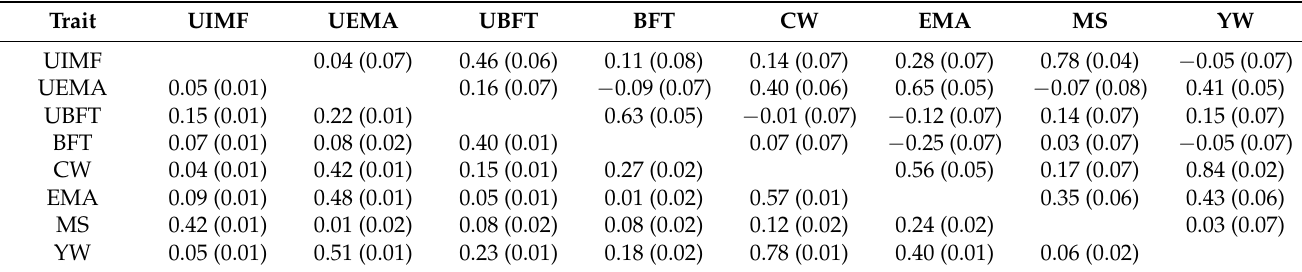
Table 3. Estimates of genetic (above diagonal) and phenotypic (below diagonal) correlations among the yearling ultrasound measurements and carcass traits in Hanwoo